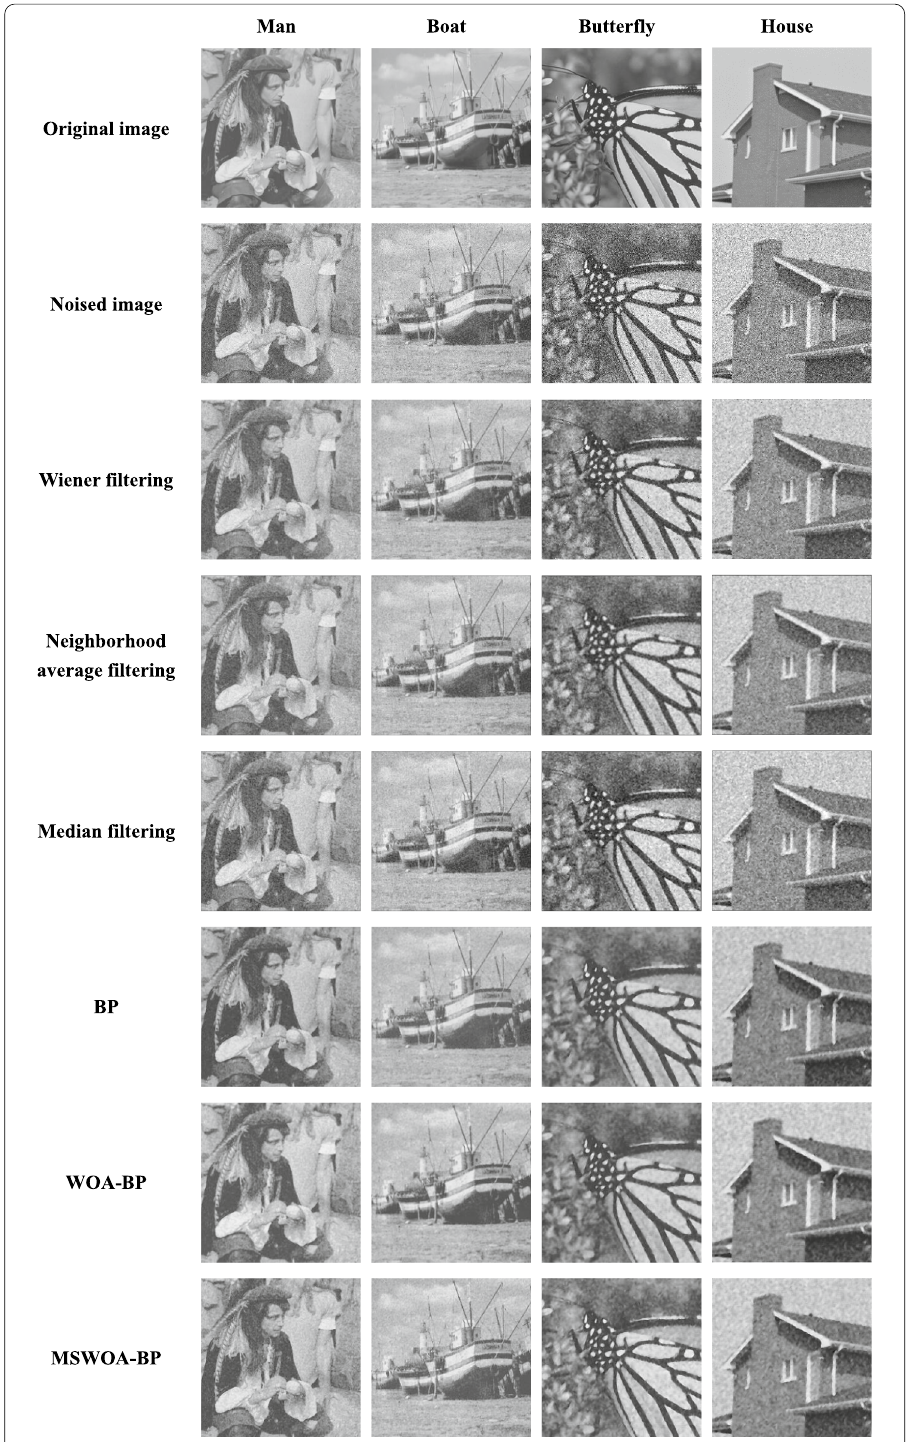
Fig. 7 Denoising effect of different denoising algorithms for benchmark